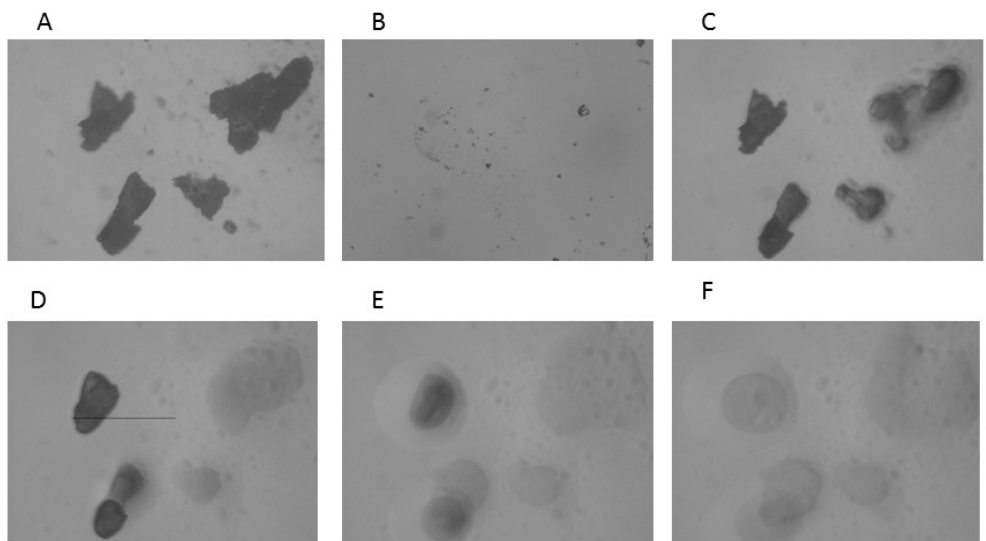
Figure 3. HSM micrographs for PU at different temperatures: ( A )—PU at 25 °C; ( B )—PU at 25 °C— back cooled product; ( C )—PU at 245 °C—melting starts; ( D )—PU at 250 °C—partially melted; ( E )— PU at 255 °C—partially melted; ( F )—PU at 260 °C—melted. The magnification in the photographs was 59.7×.